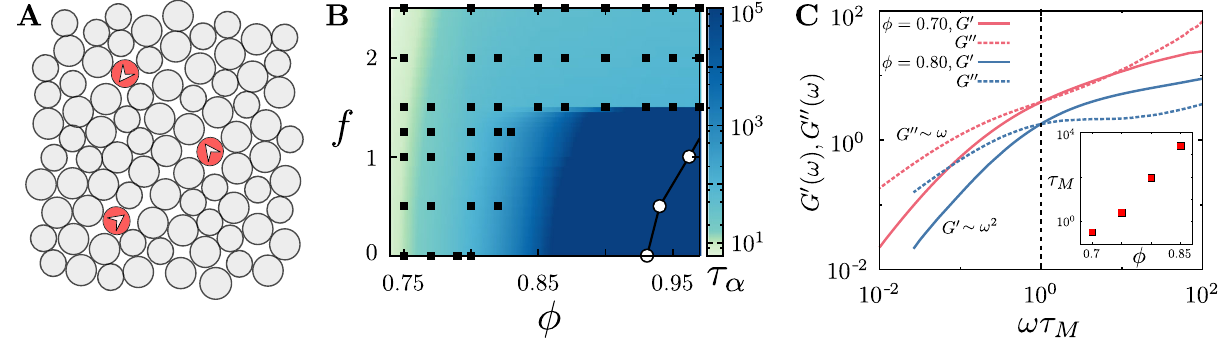
Fig. 1 | Active motile particles in a dense medium — approach to glass and vis- coelasticity. A Schematic of dilute suspension of self-propelled particles of area fraction ϕ a (red particles with arrows showing instantaneous direction n of pro- pulsive force f n ) moving through a dense compressible passive fl uid of area frac- tion ϕ (grey particles). B Dynamical phase diagram in the f − ϕ plane for fi xed T =0.5, ϕ a =0.017 and τ =50, showing macroscopic liquid and solid (glass) phases adjoining the cage-hopping “ super-cooled liquid ” regime, as determined from the α -relaxationtime, τ α (SupplementaryNote2).Theglasstransitionatdensity ϕ